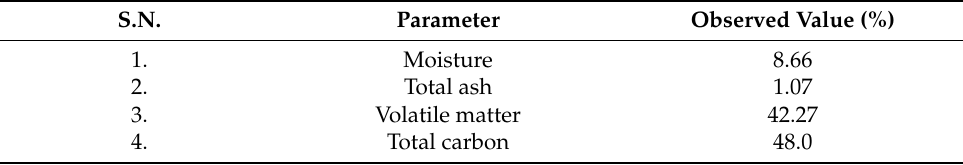
Table 3. Proximate analysis of the precursor (wood powder of Dalbergia sisoo